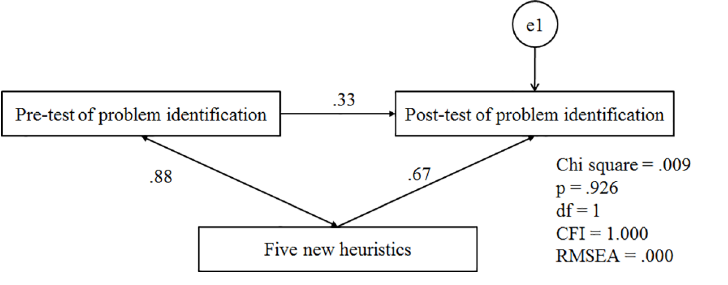
Fig 12. Analysed model when a 6¼